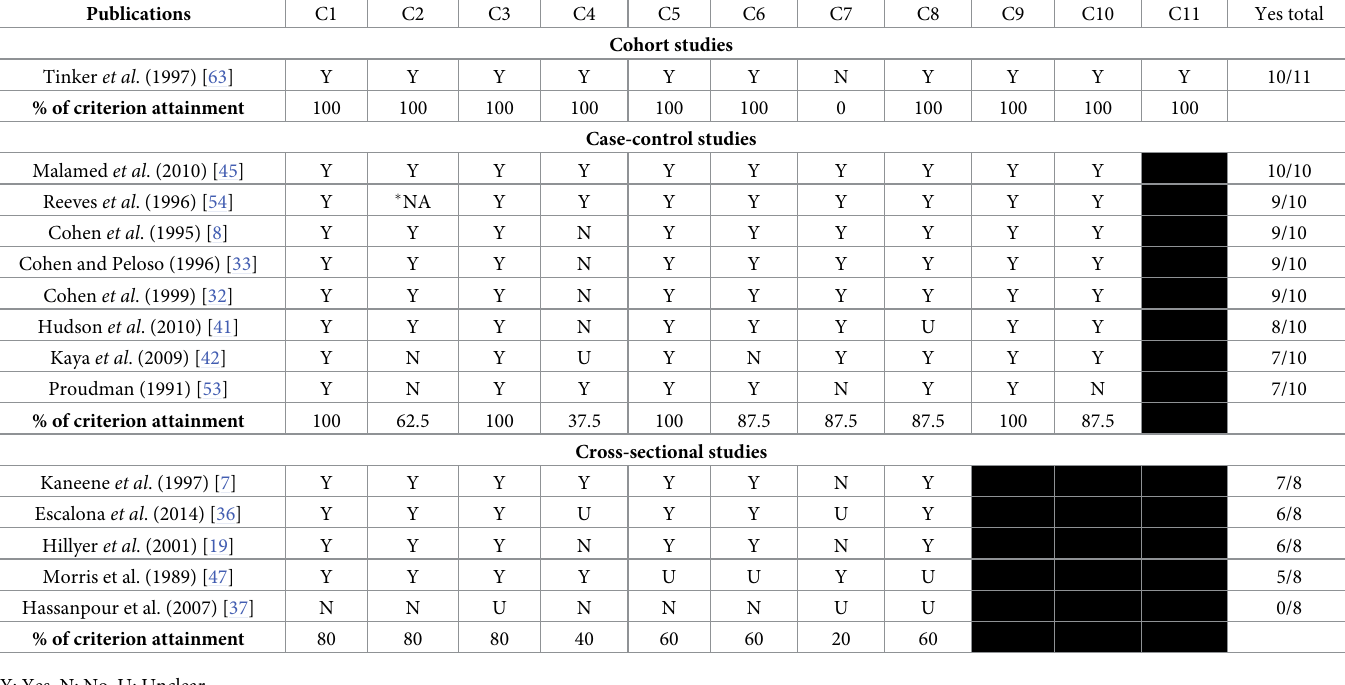
Table 7. Quality appraisal of 1 cohort, 8 case-control and 5 cross-sectional publications appraised using the JBI quality appraisal tools for publications included in a systematic review of management risk factors for colic in the horse. Criteria descriptors can be found in Supporting Information Item 2 (Systematic Review